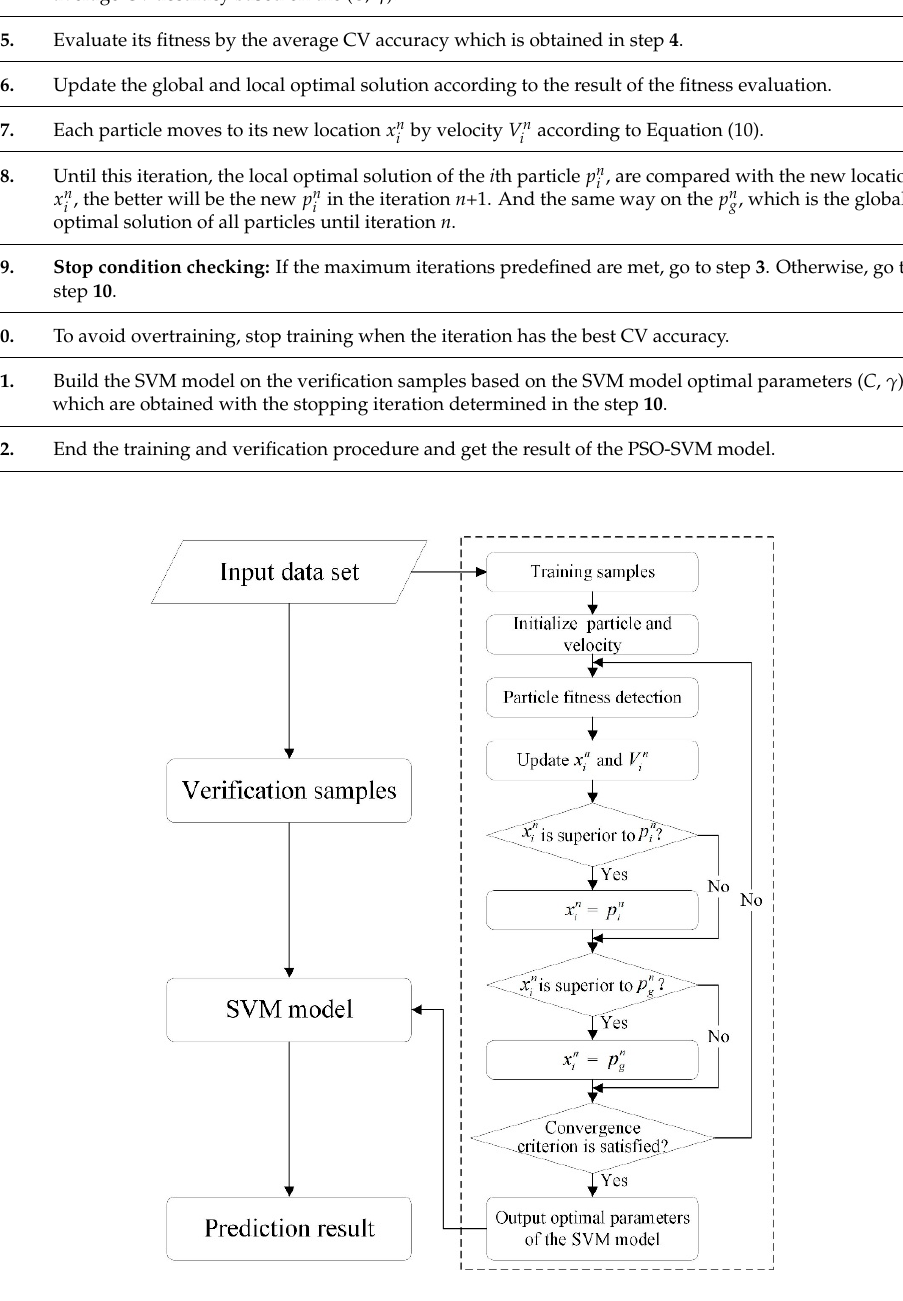
Figure 3. The flowchart of the PSO-SVM model.